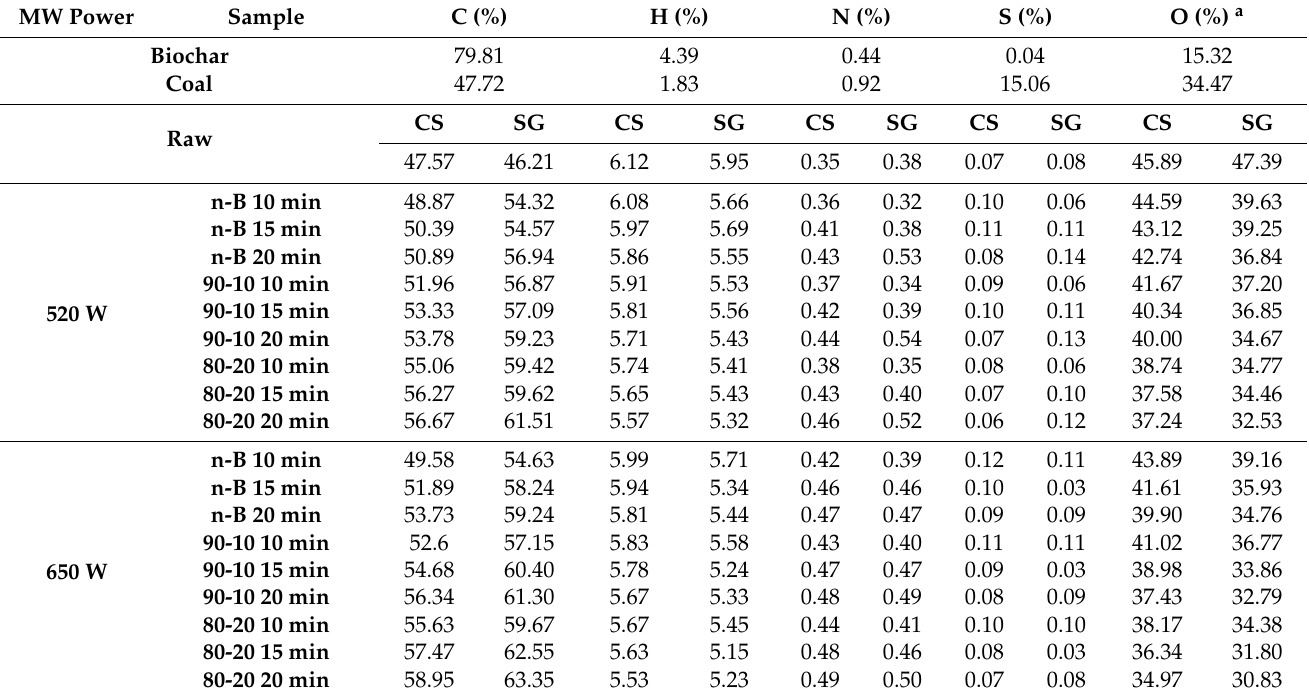
Table 2. Elemental composition of untorrefied and microwave torrefied camelina straw and switch- grass with and without